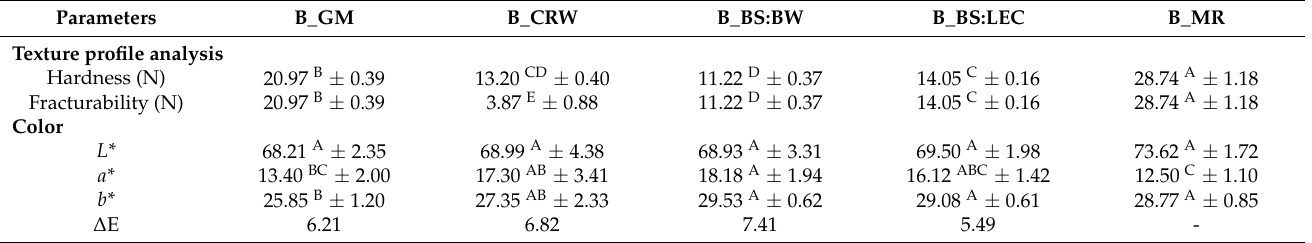
Table 3. Textural properties and color parameters of